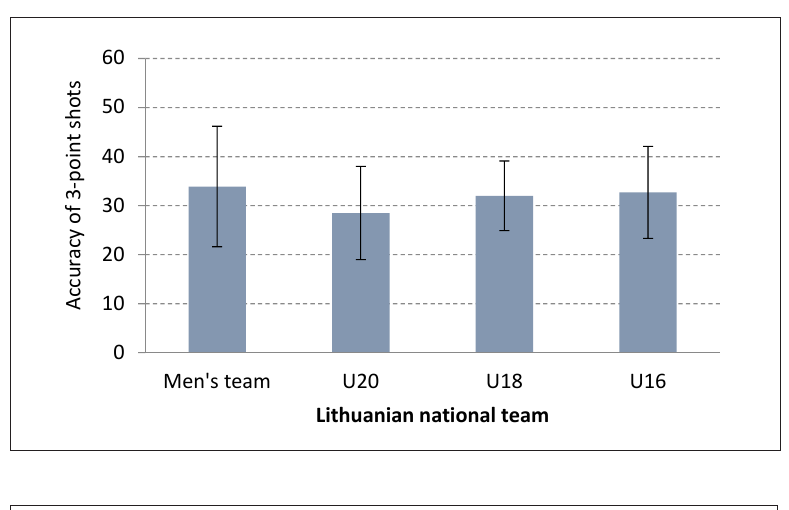
Figure 4. The accuracy of 3-point shots for men’s basketball teams in the European championship matches (average per one game)